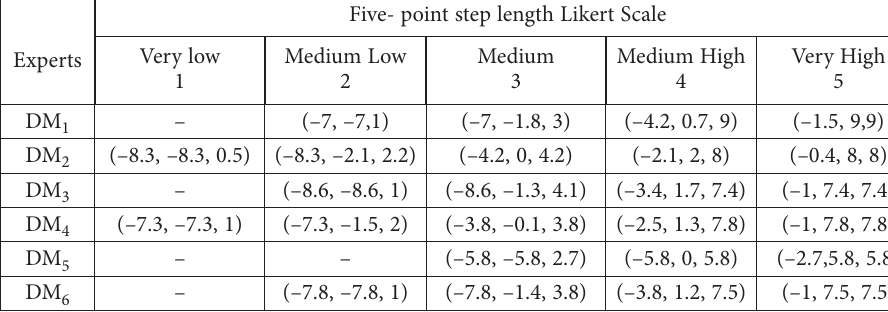
Table 4. The Linguistic variables of the